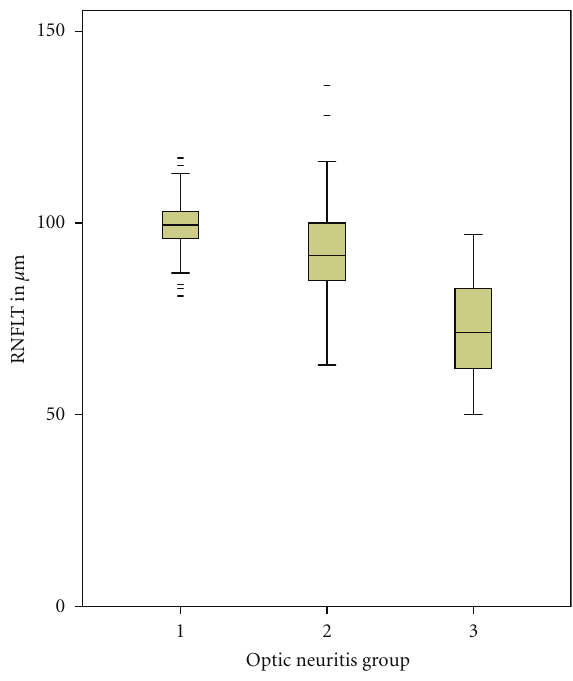
Figure 2: Boxplot of di ff erences between RNFLT in control group (left box, group 1) and groups of MS eyes without optic neuritis (center box, group 2) and MS eyes with optic neuritis (left box, group 2) measured by